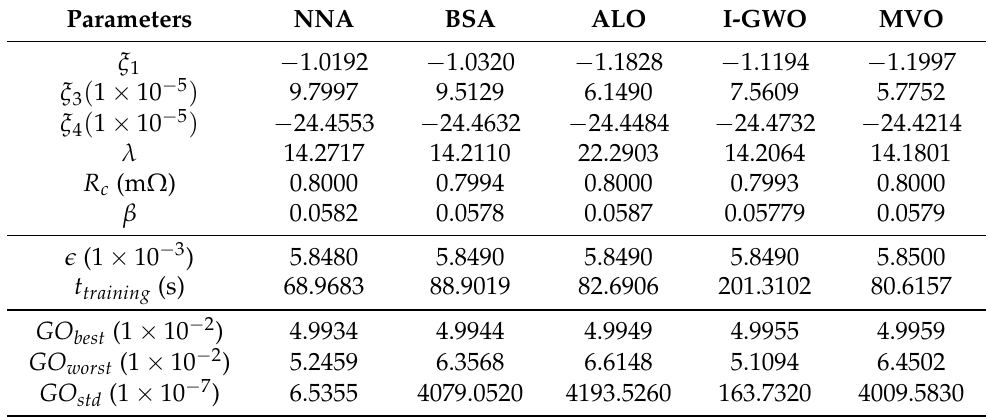
Table 6. Unknown parameters computed and performance information for the modeled polarization curve at 28% RH.